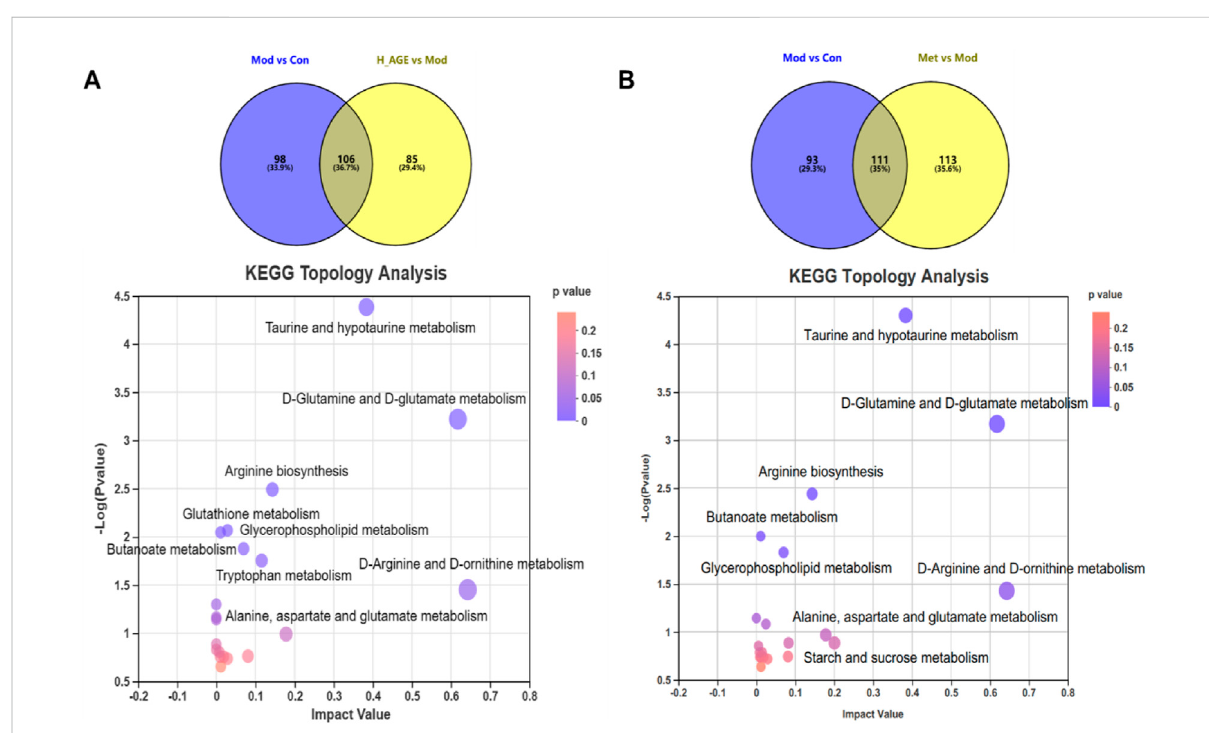
FIGURE 7 Metabolic pathway analysis. (A) refers to the pathway enrichment analysis of the intersectant metabolites between Mod vs Con and H_AGE vs Mod. (B) refers to the pathway enrichment analysis of the intersectant metabolites between Mod vs Con and Met vs Mod. The X-axis represents the impact value and the Y-axis represents – log10( p -value). The size of the bubble represents the impact value. The larger the bubble and higher the – log10( p -value), the greater the importance of the pathway.